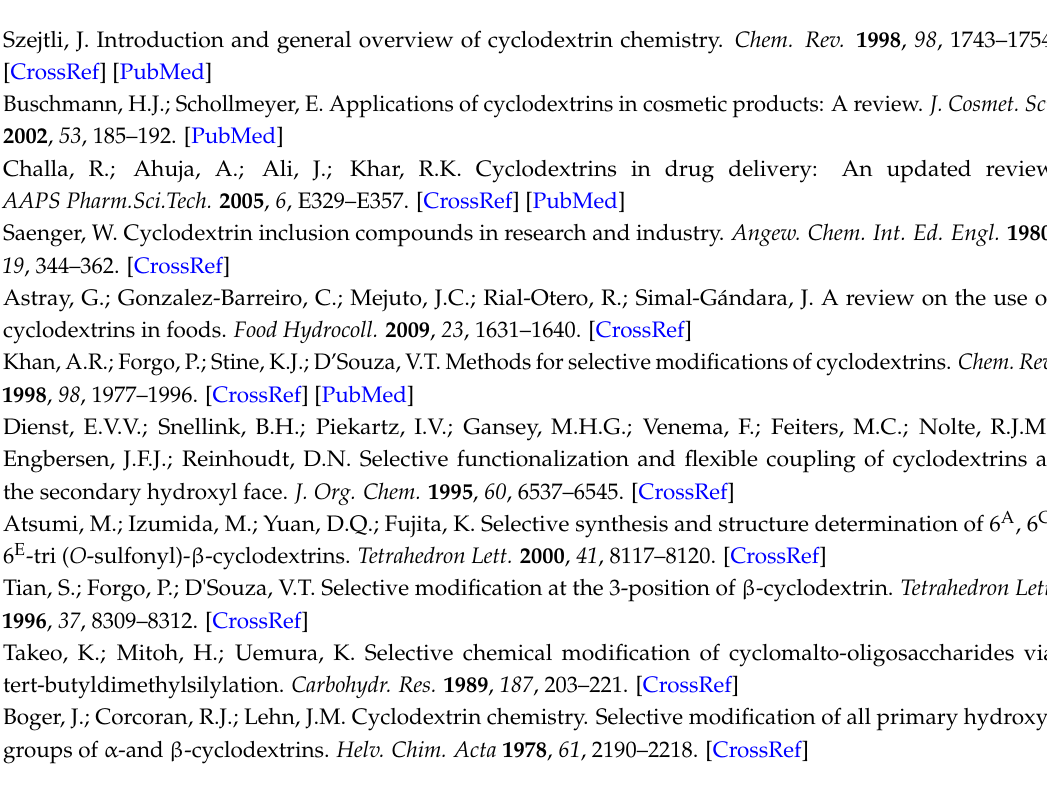
Figure S1: 1 H-NMR of 3 , Figure S2: 13 C-NMR of 3 , Figure S3: MALDI-TOF-MS of 3 , Figure S4: 1 H-NMR of 2 1 , Figure S5: MALDI-TOF-MS of 2 1